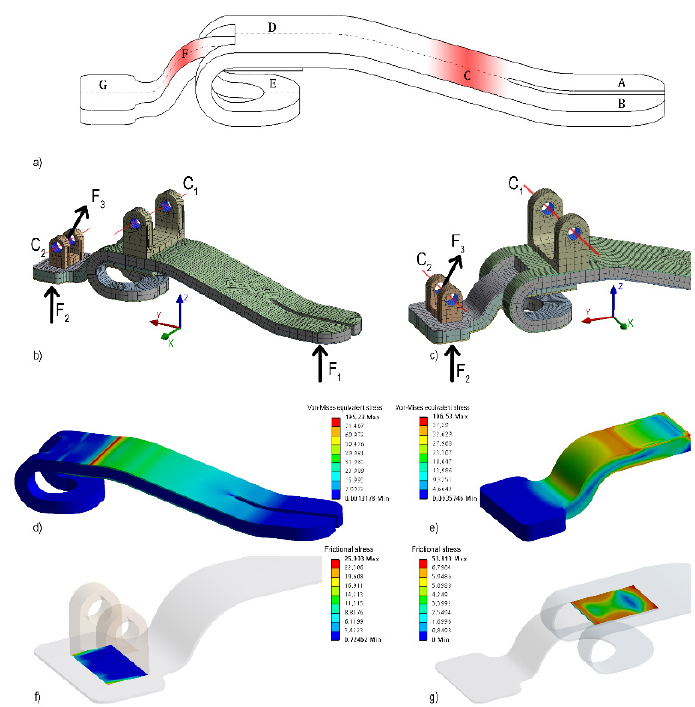
Figure 6. ( a ) Geometry of the prosthetic foot: A and B are the left and right distal areas, rispectively; C is the metatarsal area; D is the tarsal area; E is the tarsal support area; G is the calcaneal area; ( b ) and ( c ) finite element model of the foot: mesh and applied loads (F1 = 2.000 N, F2 = 2.000 N, F3 z = 1.835 N, F3 y = − 490 N); equivalent stresses: ( d ) for a critical distal load, ( e ) for a critical calcaneal load; frictional stresses: ( f ) on the glued calcaneal area; ( g ) on the glued area between the two skin-core structures.